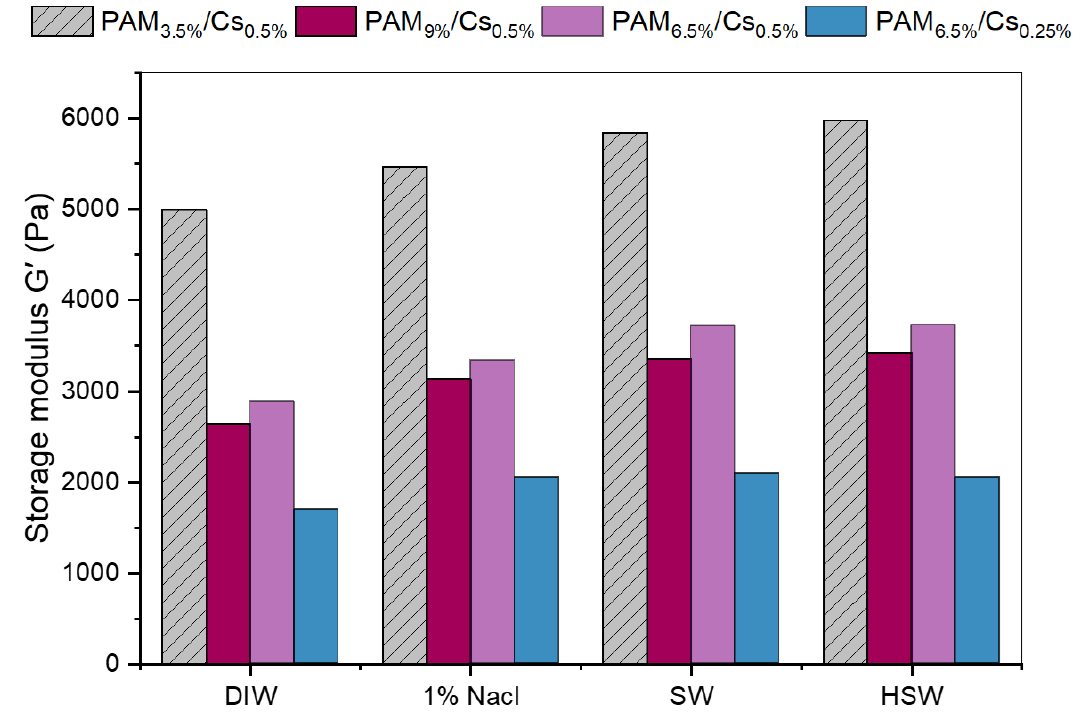
Figure 12. Storage modulus (G’) of swollen PAM/Cs in different salinity media.